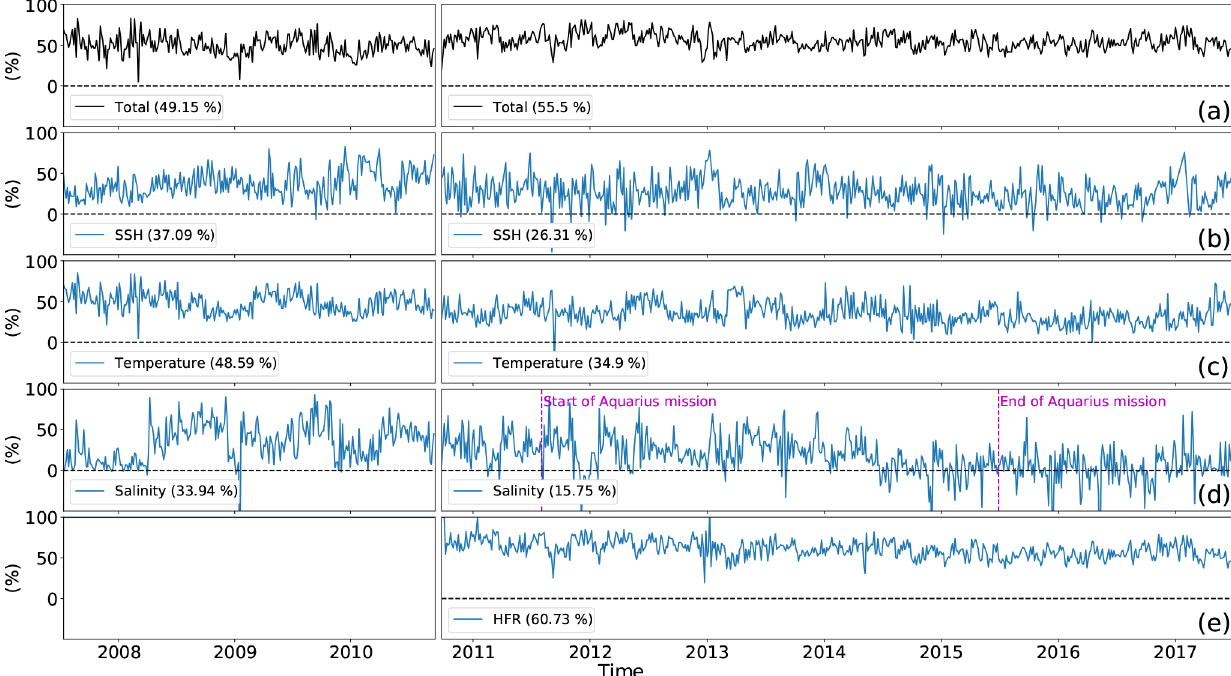
Figure 4. Time series of percentage reduction in the I4D-Var cost function; in the left column are pre-HFR observations and in the right column are post-HFR observations, with the mean value given in parentheses. Dashed lines mark the limit of 0, below which there is no reduction in the cost function for that variable. (a) Total cost function reduction for all observations; (b) sea surface height observations, (c) temperature observations; (d) salinity observations; (e) HFR